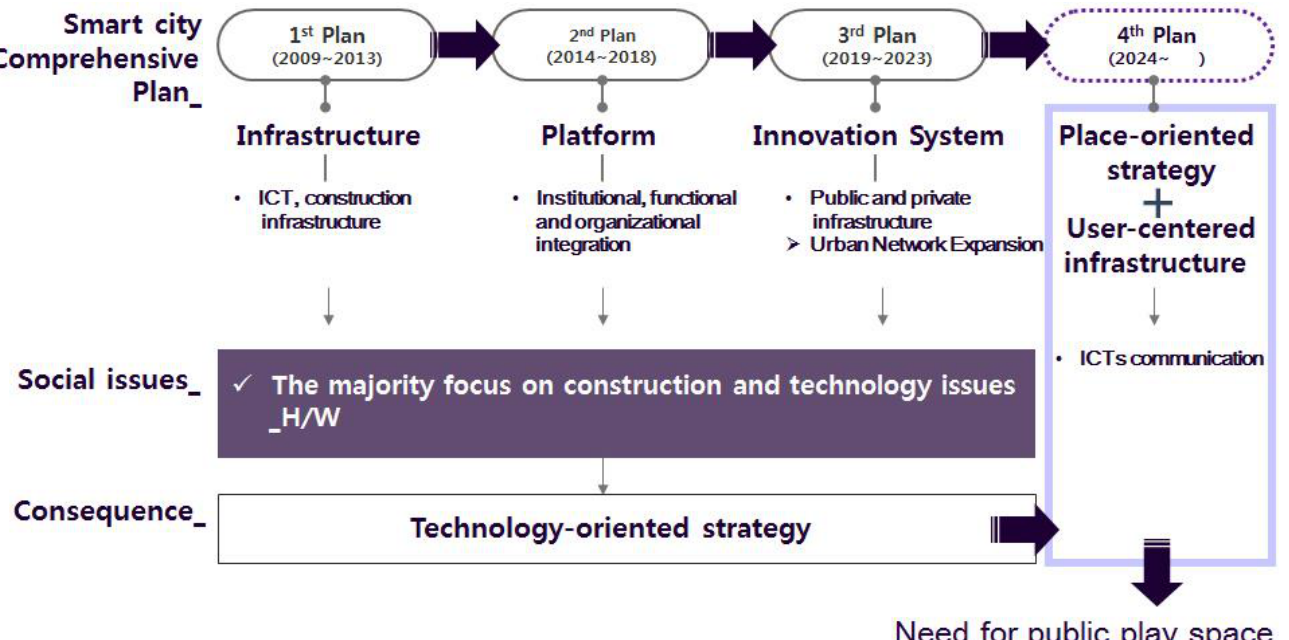
Figure 2. ICTs’ smart city platform planned by the Korean Ministry of Land, Infrastructure, and Transport.